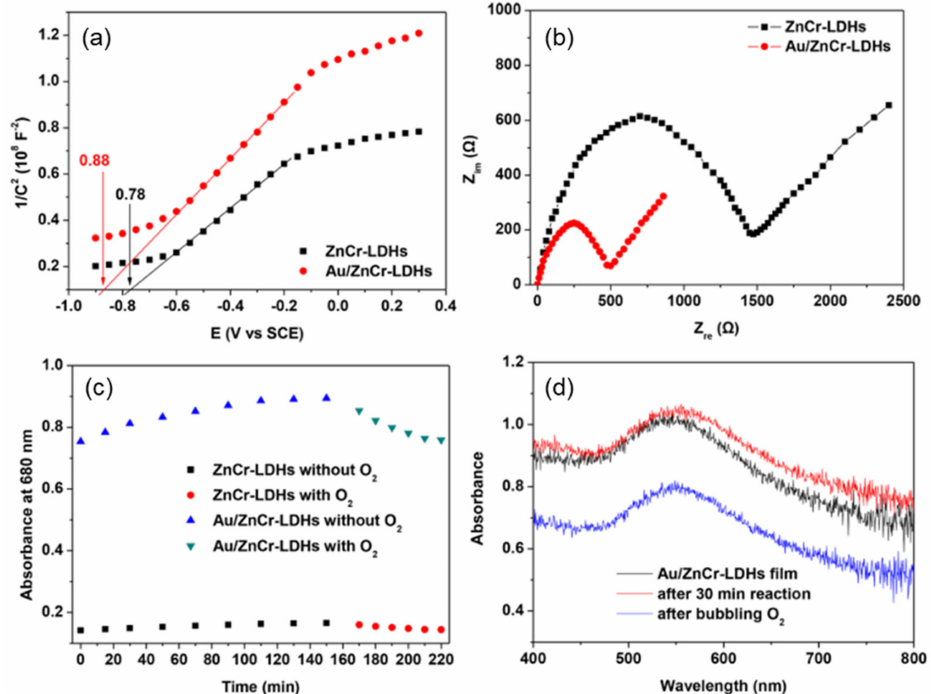
Figure 7. ( a ) Mott–Schottky (MS) graphs and ( b ) electrochemical impedance spectra (EIS) Nyquist graphs of ZnCr–LDHs and Au/ZnCr–LDHs electrodes; differences in absorbance at 680 nm for the open-circuited ZnCr-LDHs and Au/ZnCr-LDHs films under exposure to visible light irradiation ( c ) prior and ( d ) after O 2 bubbling in a N 2 -saturated acetonitrile ethylene glycol mixture prepared by adding 0.1 mol/L LiNO 3 and 0.5 mol/L ethanol. Note: the EIS experiments were carried out with a redox sample of 0.50 mol/L Na 2 SO 4 and 2.5 mmol/L K 3 [Fe(CN) 6 ]/K4[Fe(CN) 6 ] aqueous